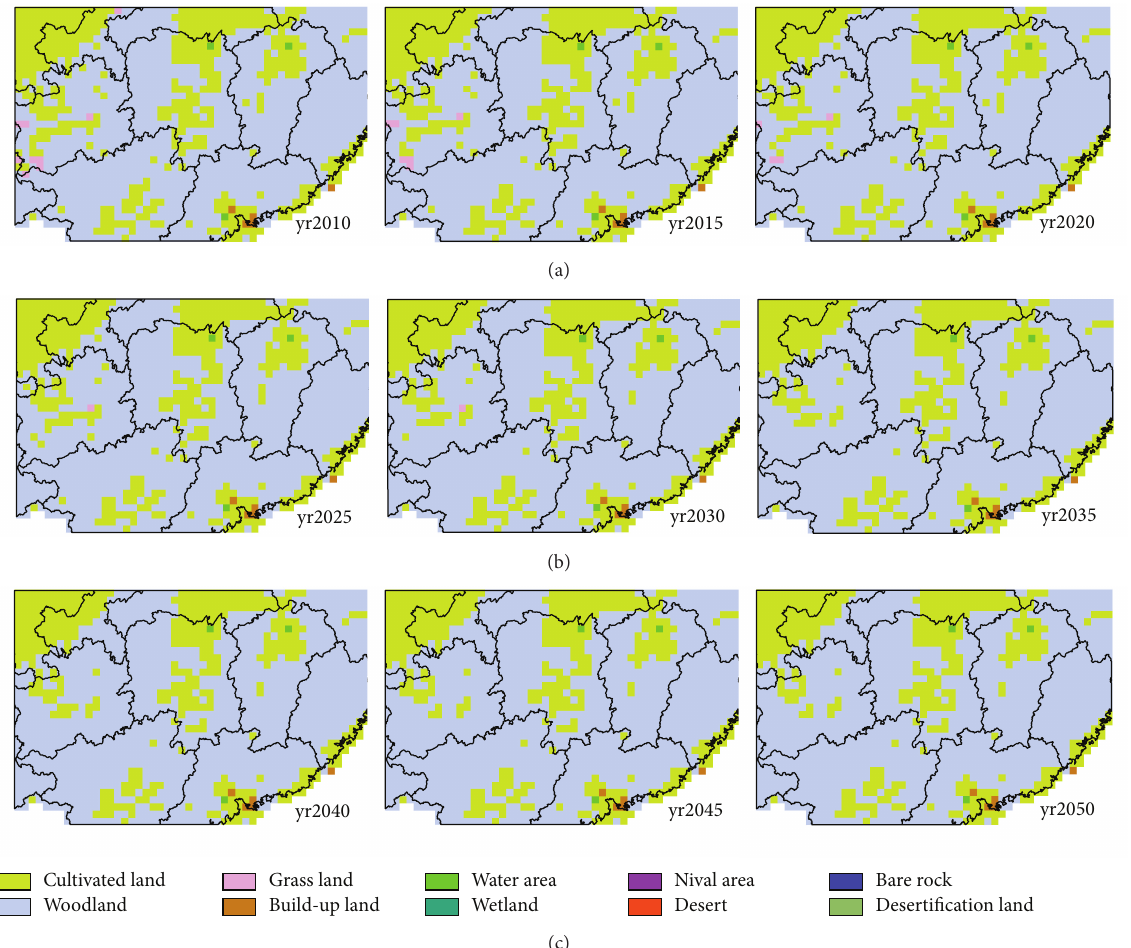
Figure 2: Spatial dynamics of A2a land cover change scenario in the next 40 years.